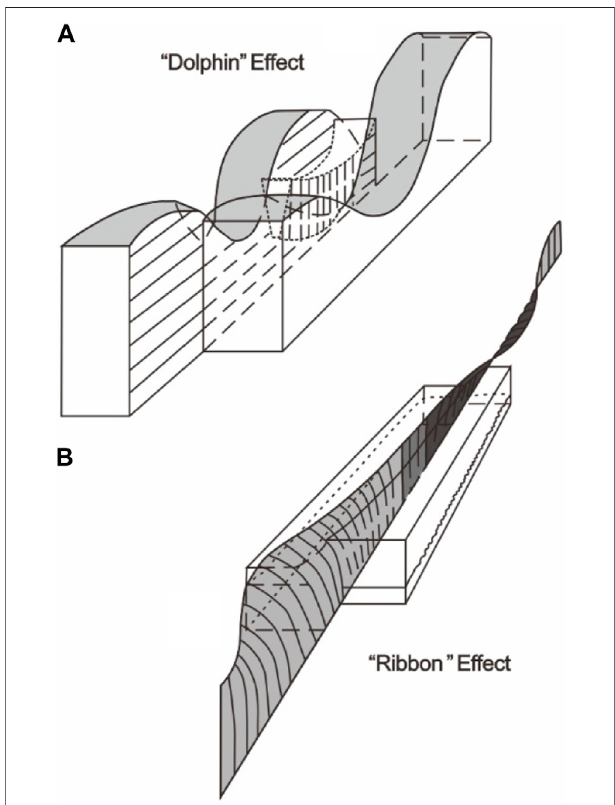
FIGURE 7 | Patterns of dolphin effect (A) and Ribbon effect (B)